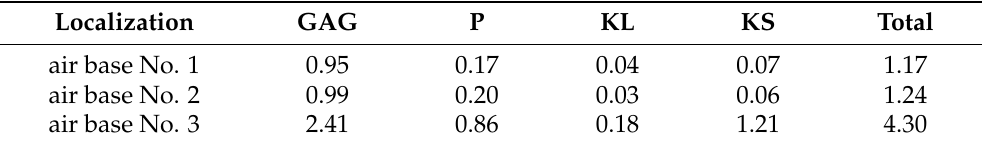
Table 5. Mean Landing Fatigue Equivalent values corresponding to different types of cycles with respect to operations performed from different air